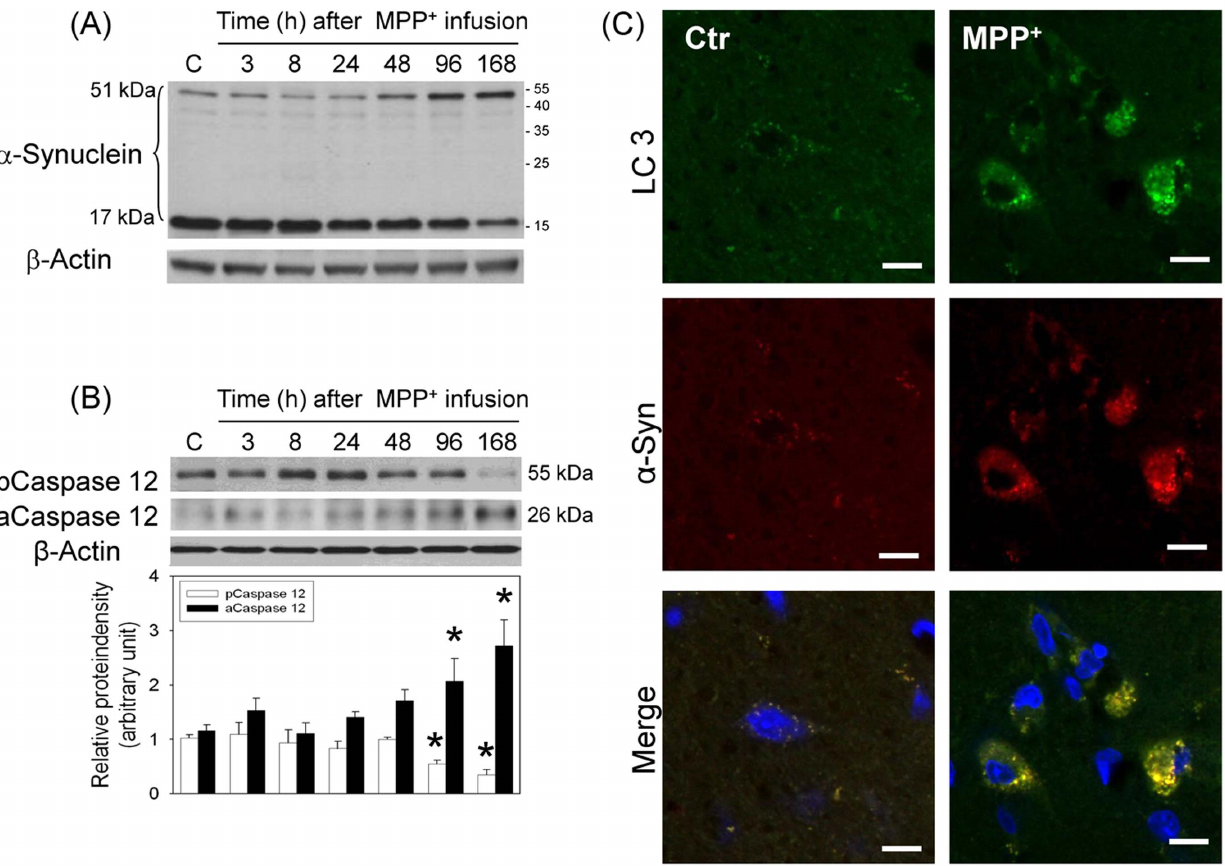
Figure 5. Effect of MPP + on a -synuclein aggregation in the nigrostriatal dopaminergic system of rat brain. Intranigral infusion of MPP + (3 m g/ m l) was performed in the anesthetized rats. Rats were sacrificed at the indicated times. (A) Representative data show time-dependent effects of MPP + on a -synuclein aggregation in the substantia nigra (SN) using Western blot assay. Results were repeated with independent experiments. ( n =3) (B) Time-dependent effects of MPP + on caspase 12 activation in SN were studied using Western blot assay. Each lane contained 25 m g protein for the experiments. Graphs show statistical results from relative optical density of bands on the blots estimated by Image J software. Values are the mean 6 S.E.M. (n=5/group). *P , 0.05 in the MPP + -treated groups compared with the control groups by one-way analysis of variance (one-way ANOVA) and followed by the LSD test as post-hoc method. (C) Representative immunostaining shows co-localization of LC3 (green) and a -synuclein (red) in the MPP + -infused SN. Nuclear staining was indicated by blue. Results were repeated with independent